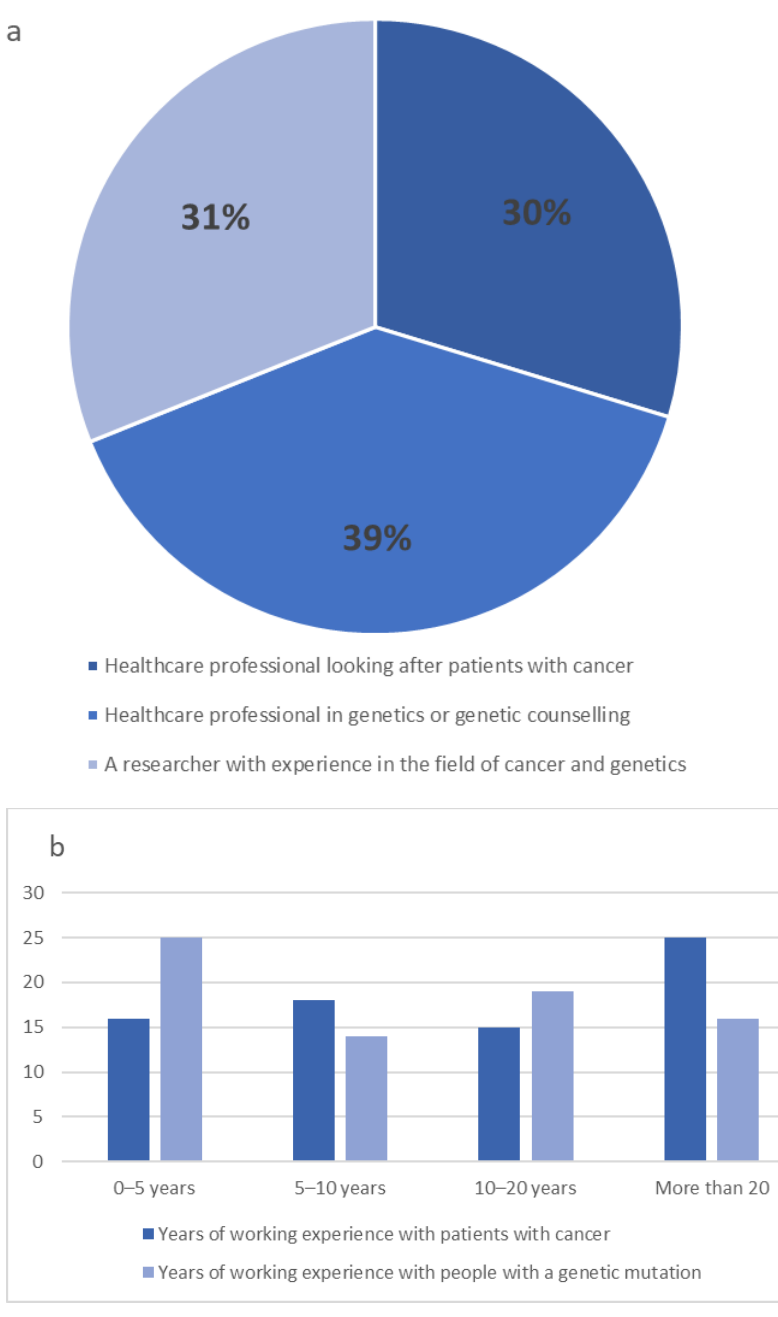
Figure 2. Description of the Delphi participants ( a ) Clinical experience of the Delphi participants ( b ) Years of experience of the Delphi participants.